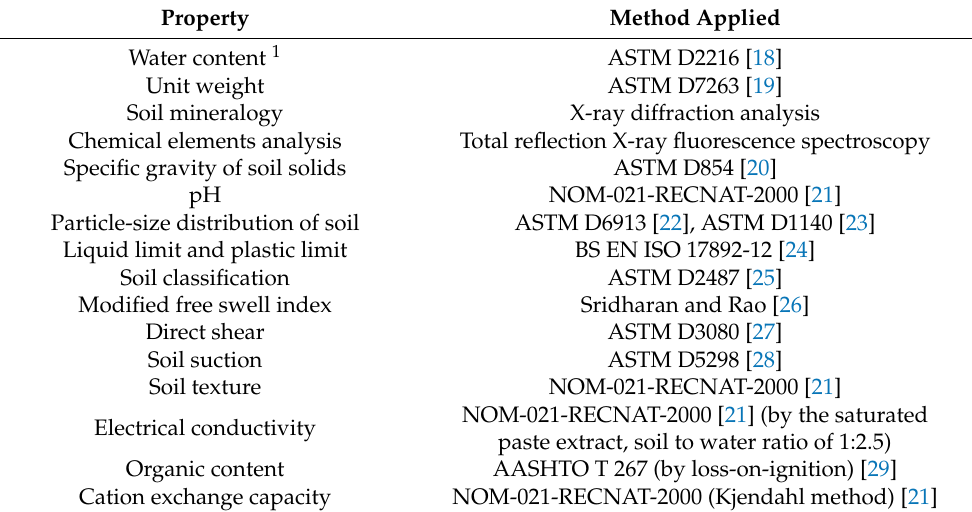
Table 2. Evaluated properties of both natural and diesel contaminated